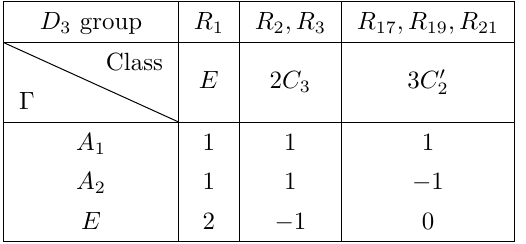
Table 10 . Character table for the D 3 group. The group elements R i are listed in table